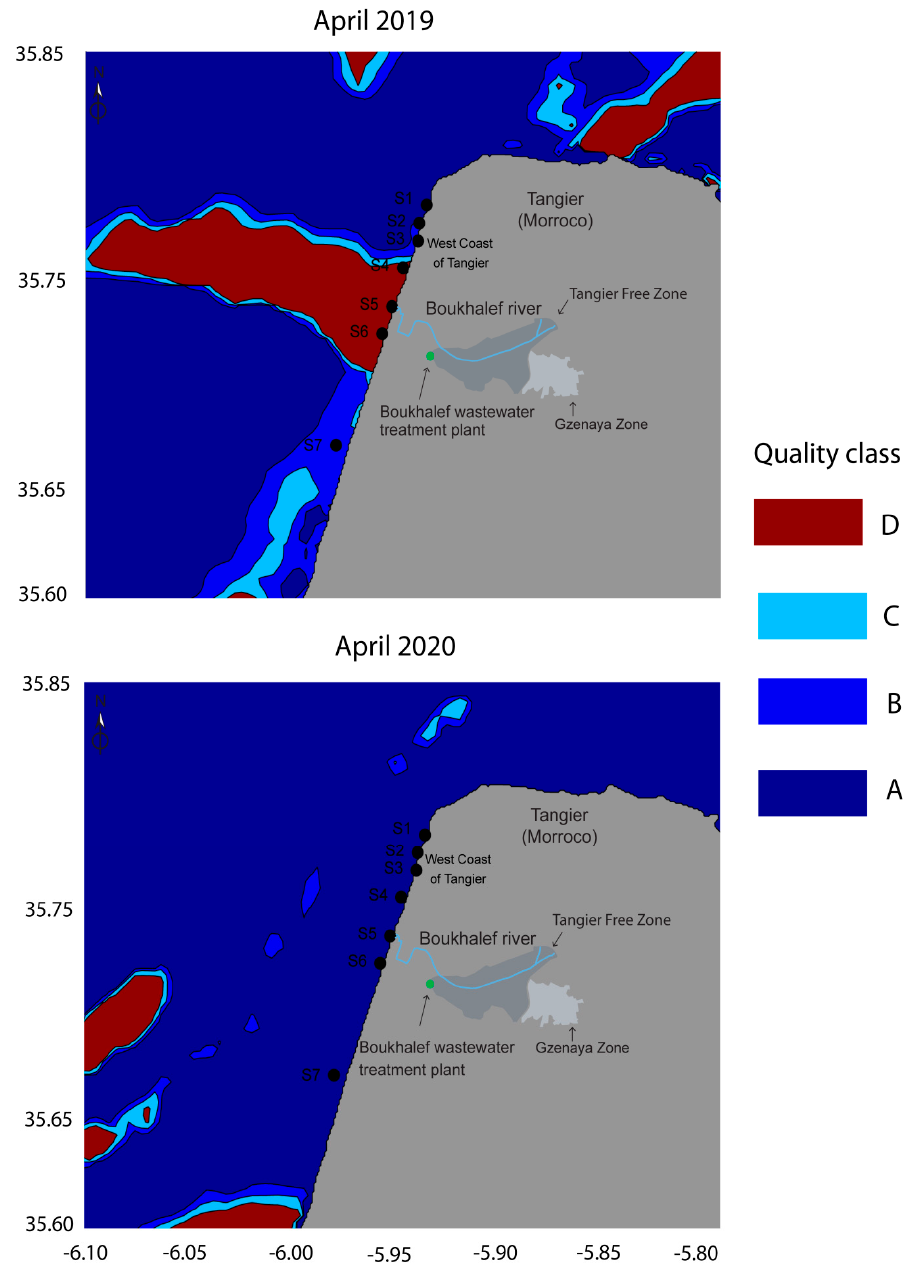
Figure 10. The average coastal water quality in Tangier and its surroundings during April 2019 and 2020.